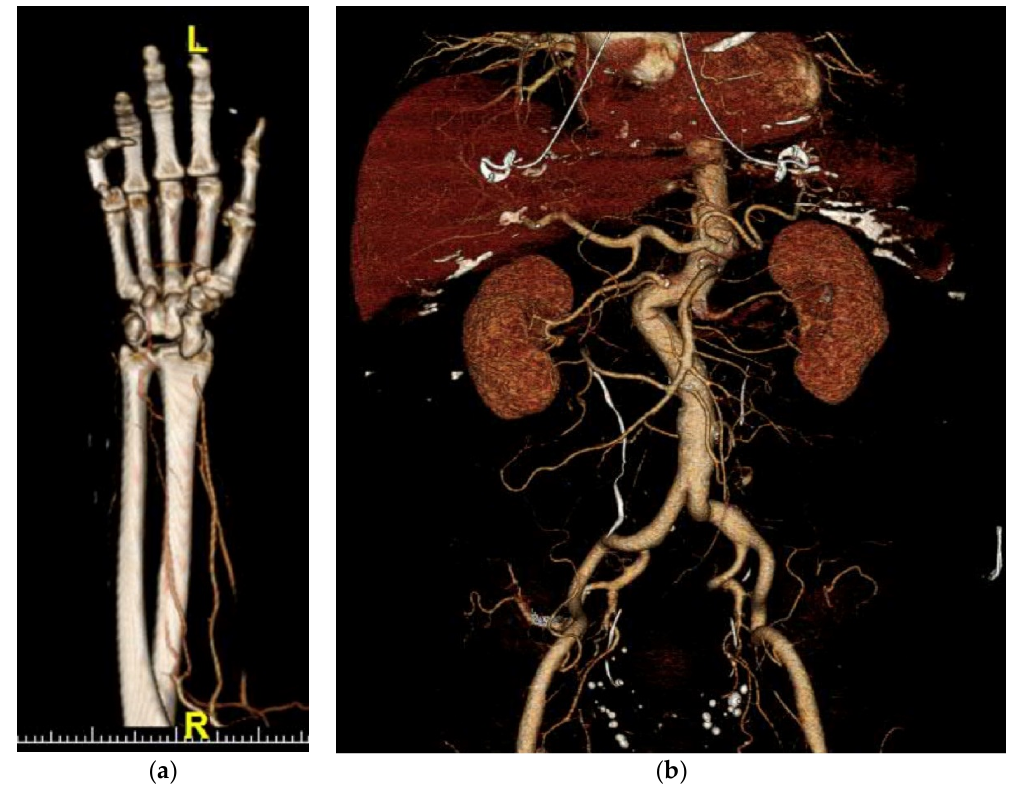
Figure 2. Volume rendering examples: ( a ) Volume rendering of distal radial artery occlusion; ( b ) Volume rendering of abdominal arteries.